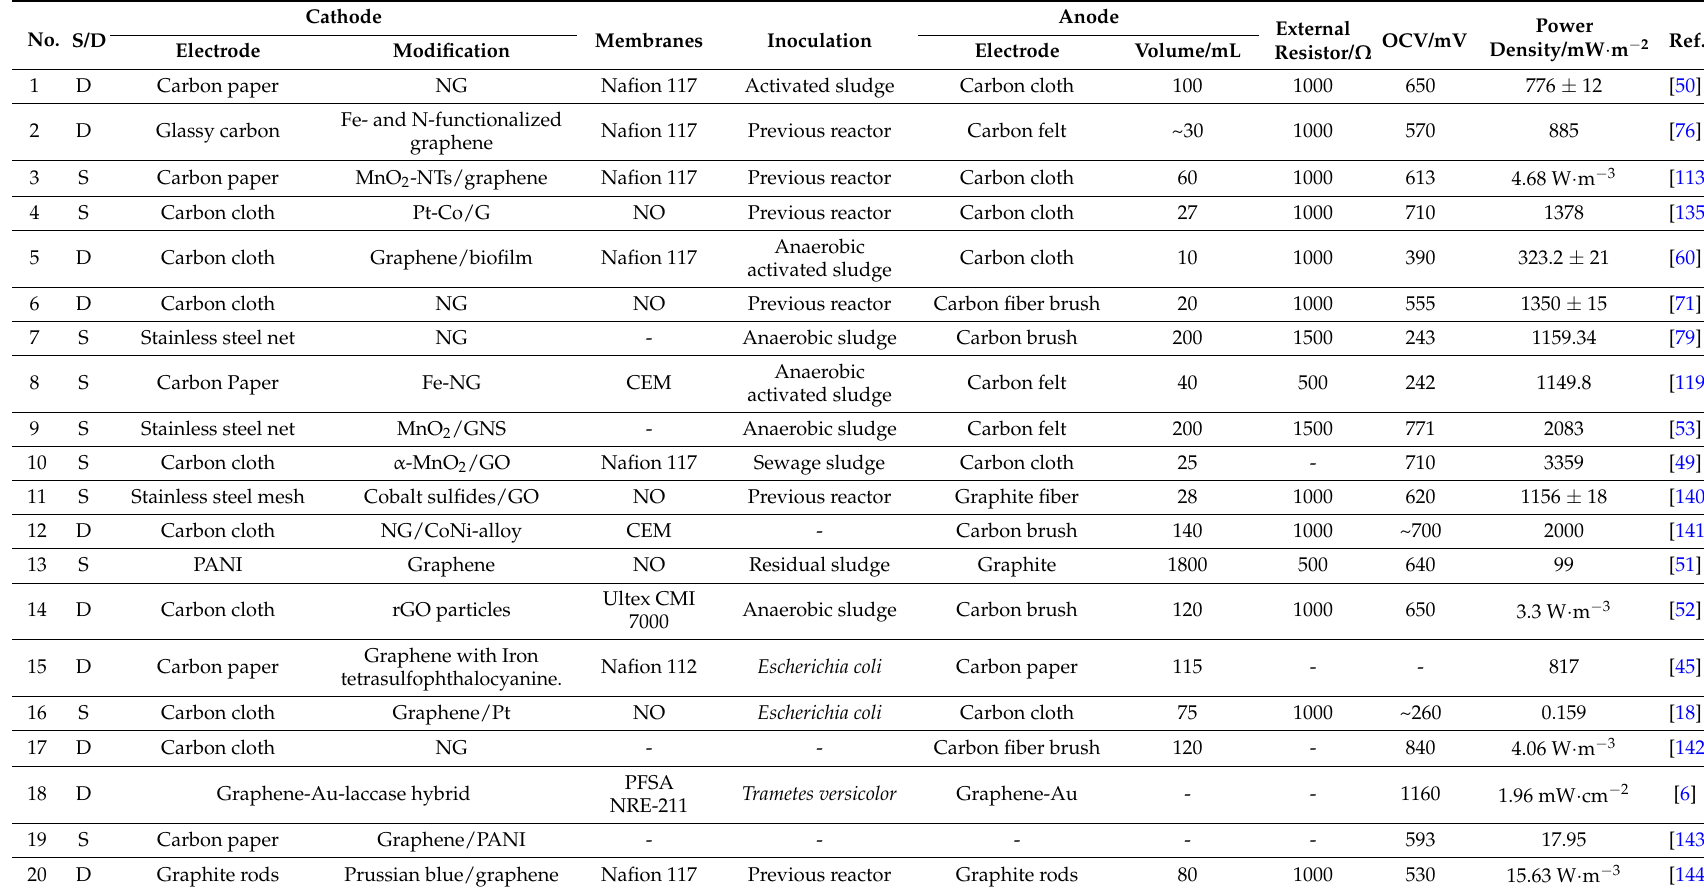
Table 2. Summary of MFC cathode electrode